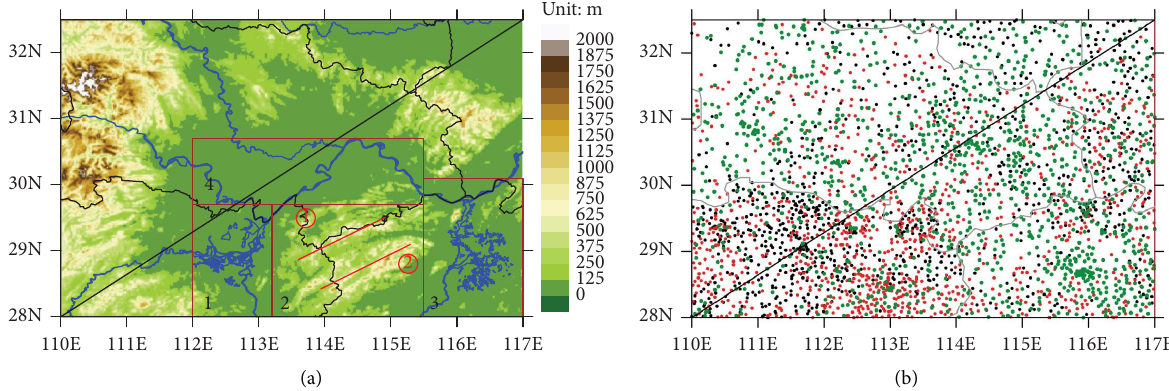
Figure 1: Topography and the location of subregions (a); distribution of ground observation stations (b). Figure 1(b), black points represent rainfall stations, red points are stations together with rainfall and temperature observation, green points are stations together with rainfall, temperature, and wind observation, and the gray solid line is the provincial boundary.